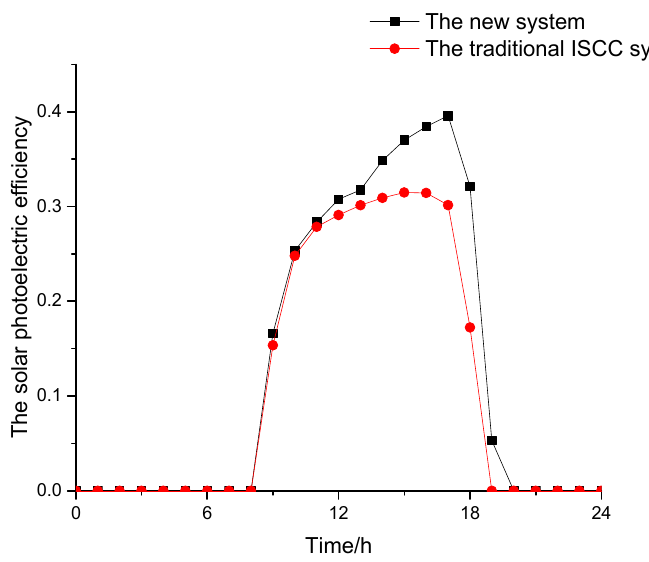
Figure 13. Solar photoelectric efficiencies of the traditional ISCC and the new system in a typical summer day.